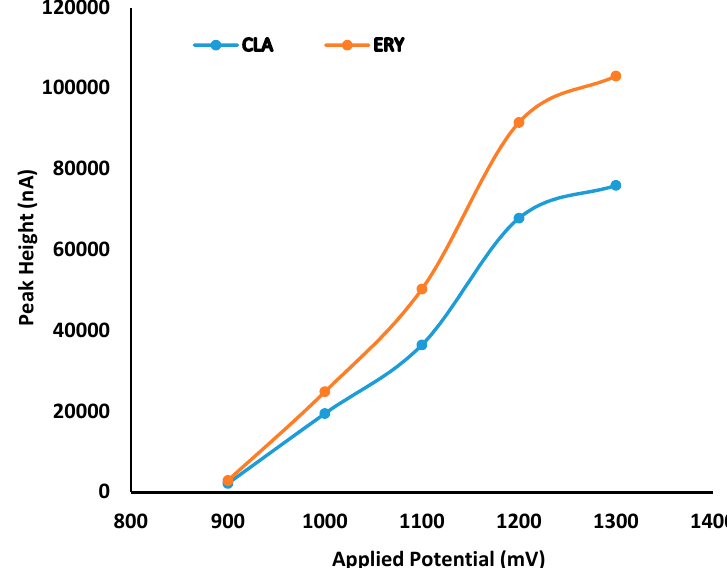
Figure 2. Hydrodynamic voltammogram (HDV) for CLA and erythromycin (ERY) generated in direct current (DC) mode at a sensitivity of 100 nA.